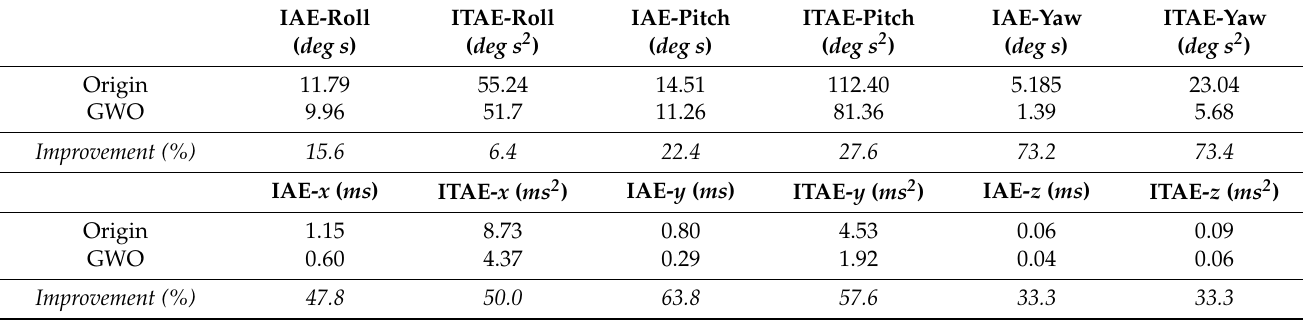
Table 6. Original and optimised comparison in IAE and